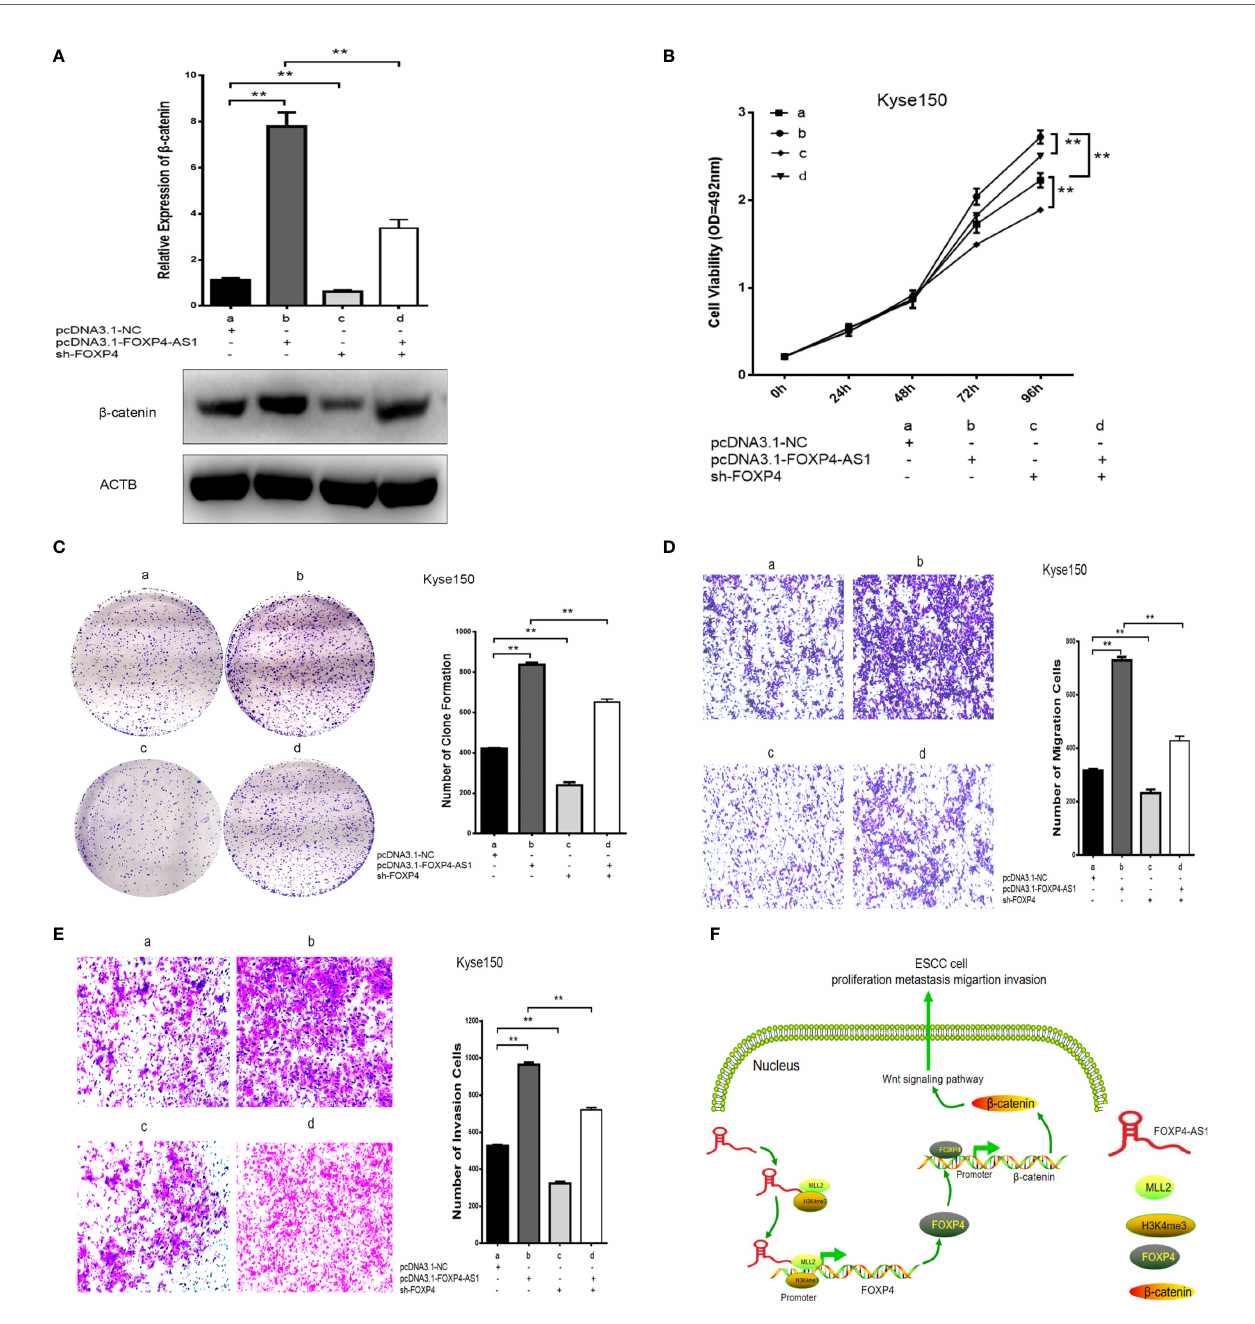
FIGURE 7 | Coexpression of FOXP4-AS1 and FOXP4 promotes b -catenin expression and ESCC progression. (A) The mRNA and protein levels of b -catenin with FOXP4-AS1 and FOXP4 by qRT ‐ PCR or WB. The effect of FOXP4-AS1 and FOXP4 coexpression on ESCC cell proliferation by MTS (B) or Colony formation (C) assay. FOXP4-AS1 and FOXP4 coexpression on ESCC cell migration (D) and invasion (E) by Transwell assay. (F) The possible molecular mechanisms for the involvement of FOXP4-AS1 in ESCC progression. ** p <